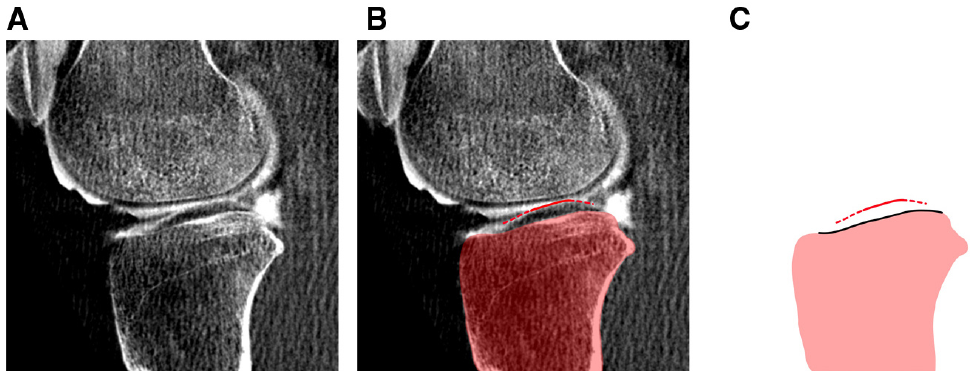
Figure 1: Segmentation in the sagittal view of the gray-scale data. (A) Original gray scale image. (B) Overlay of an exem- plary segmentation: tibia shaded in red; cartilage contact region segmented in standing scans marked as solid red line; larger region segmented in supine scan marked as dotted red line. (C) Segmentation only; region on tibial surface used for thickness calculation marked as solid black line.